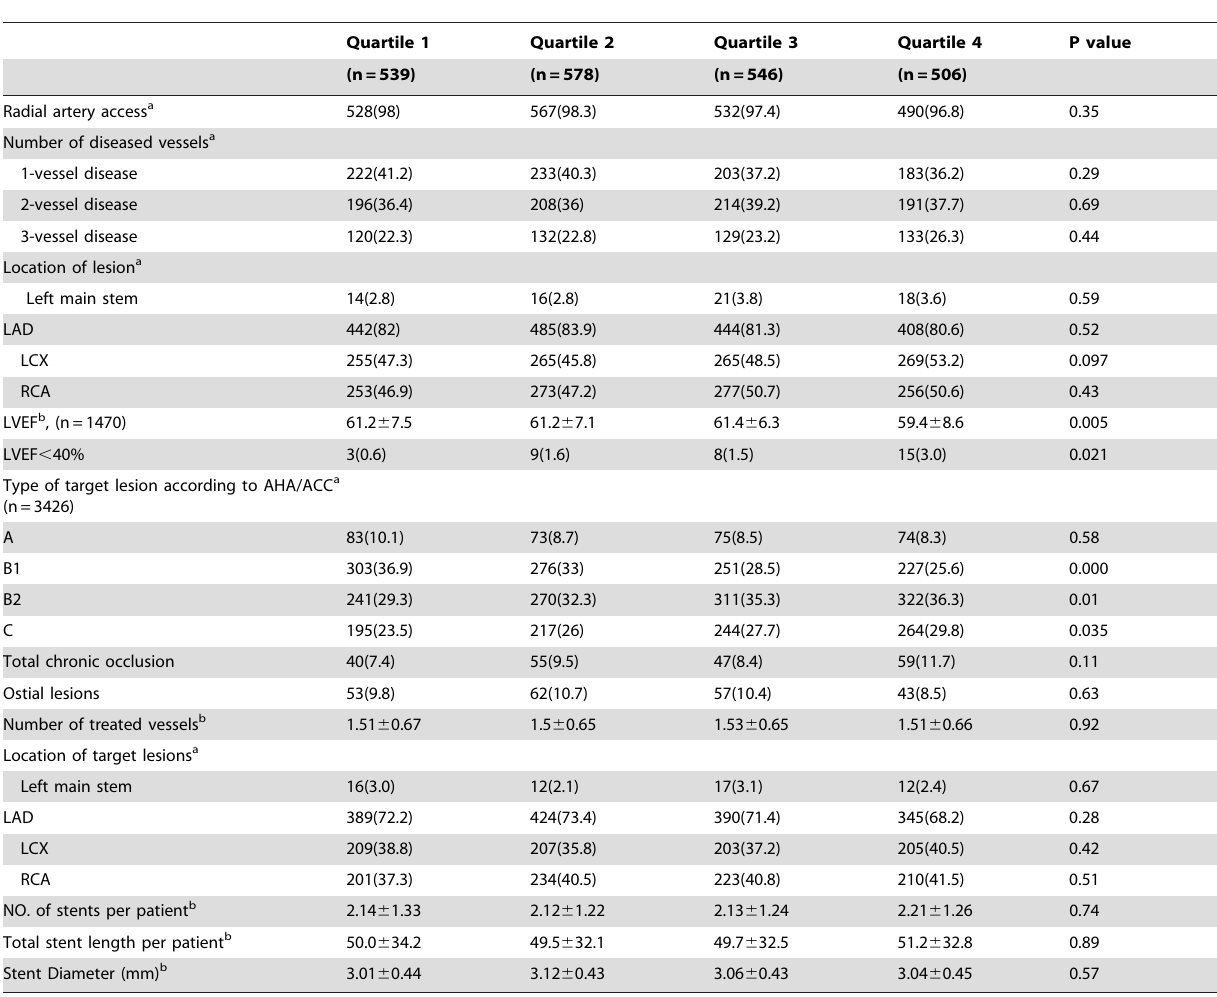
Table 2. Baseline angiographic and procedural characteristics of participants by Quartile of